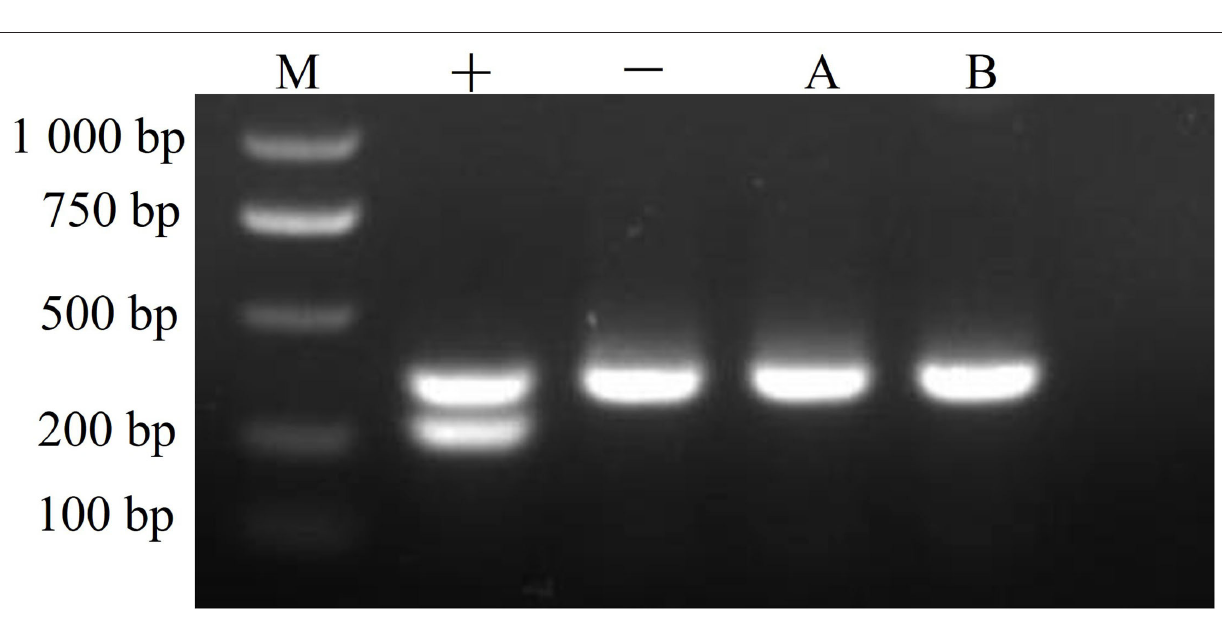
IHC results indicated that CMT-1026 was a basal epithelial cell line, and its positive expression of cytokeratin 5/6 (for basal epithelial cells) (55), α -SMA (for myoepithelial cells) (56),